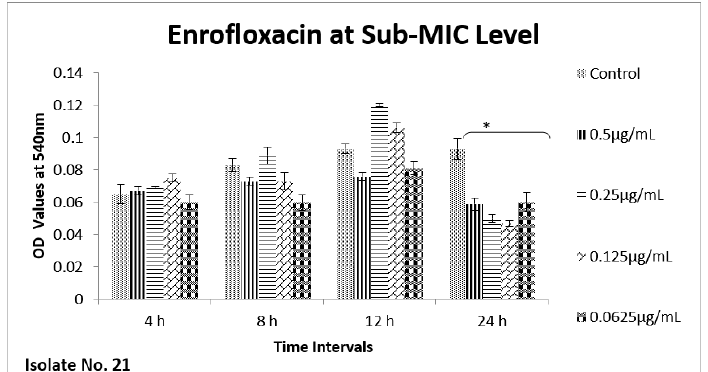
Figure 5. Shown are the effects of enrofloxacin on bacterial biofilm at different time points (OD 540 nm). Bar graph represents significant reduction (* p value < 0.05) in biofilm formation after 24 h of incubation when compared to the control samples.